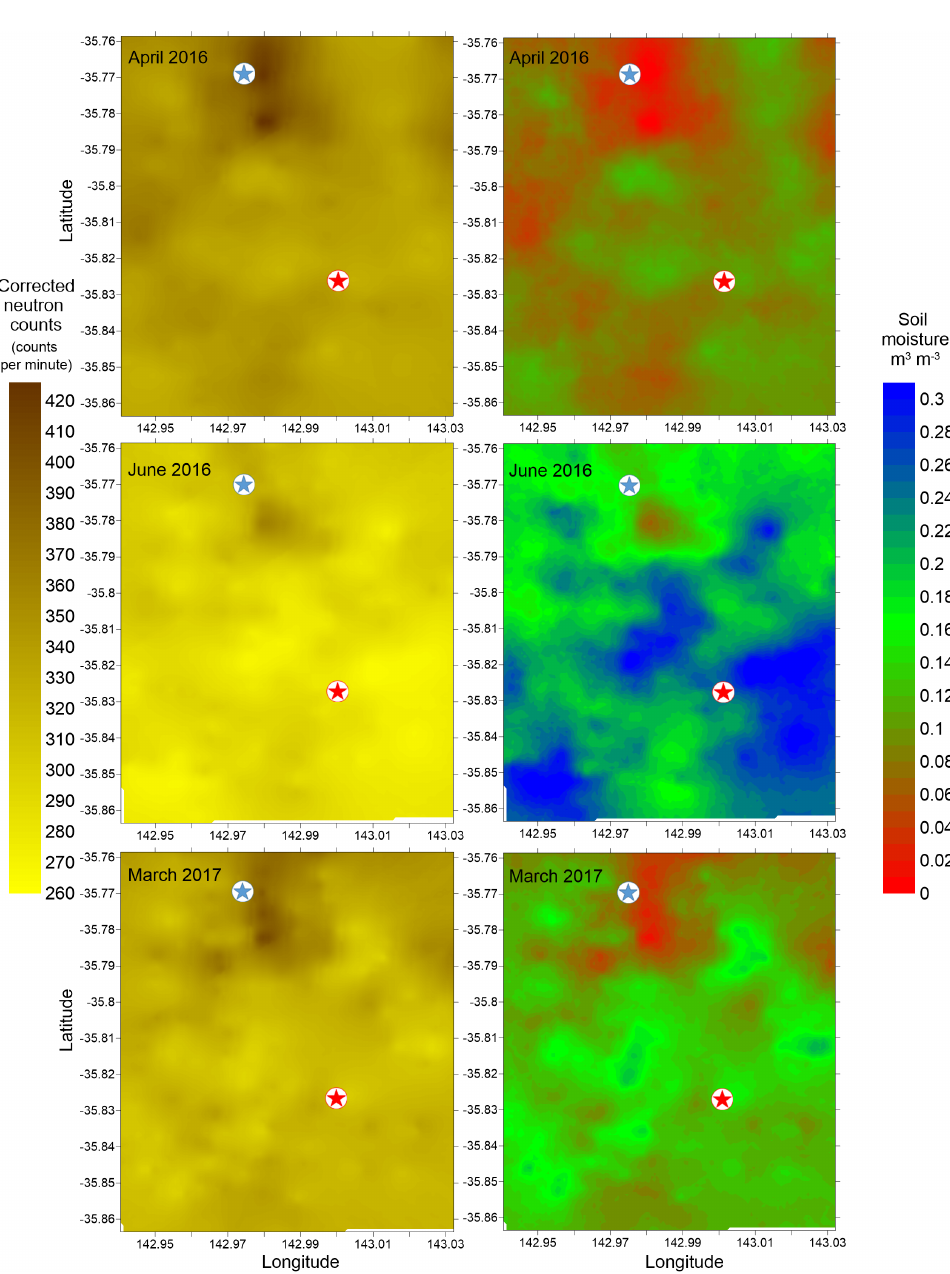
Figure 7. Interpolated corrected neutron counts (left column) and derived soil moisture (right column) for the three intensive-scale surveys during April 2016, June 2016 and March 2017. Blue and red stars indicate the location of the Bishes and Bennetts cosmic-ray neutron